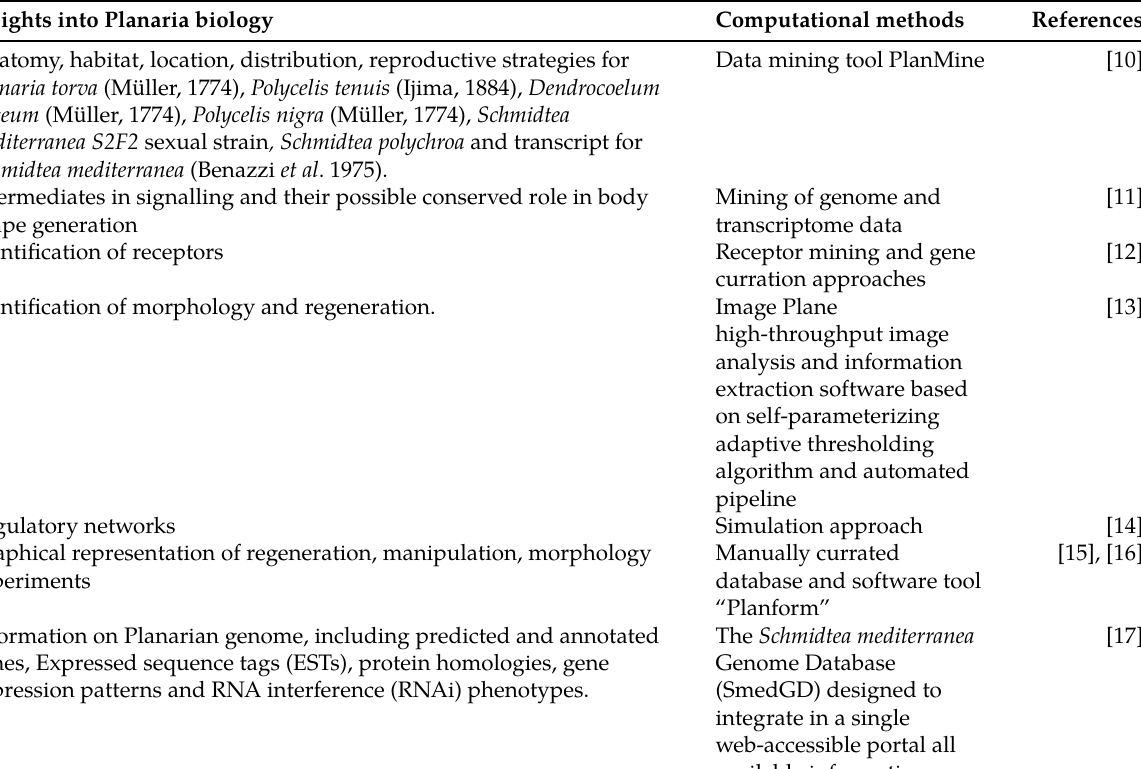
Table 3: Applications of computational methods in Planaria research. Insights into Planaria biology Computational methods Anatomy, habitat, location, distribution, reproductive strategies for Planaria torva (M ü ller, 1774), Polycelis tenuis (Ijima, 1884), Dendrocoelum lacteum (M ü ller, 1774), Polycelis nigra (M ü ller, 1774), Schmidtea mediterranea S2F2 sexual strain , Schmidtea polychroa and transcript for Schmidtea mediterranea (Benazzi et al . 1975). Intermediates in signalling and their possible conserved role in body shape generation Identification of receptors Receptor mining and gene Identification of morphology and regeneration. Image Plane Regulatory networks Simulation approach Graphical representation of regeneration, manipulation, morphology experiments Information on Planarian genome, including predicted and annotated genes, Expressed sequence tags (ESTs), protein homologies, gene expression patterns and RNA interference (RNAi) phenotypes.